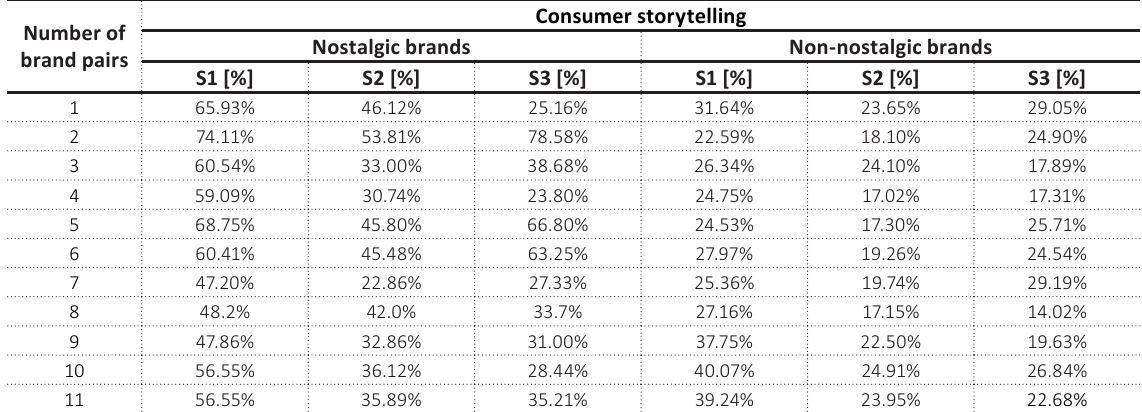
Source: Own study.